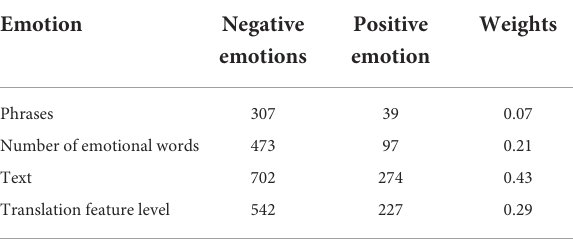
TABLE 3 Statistical examples of emotional features in discourse